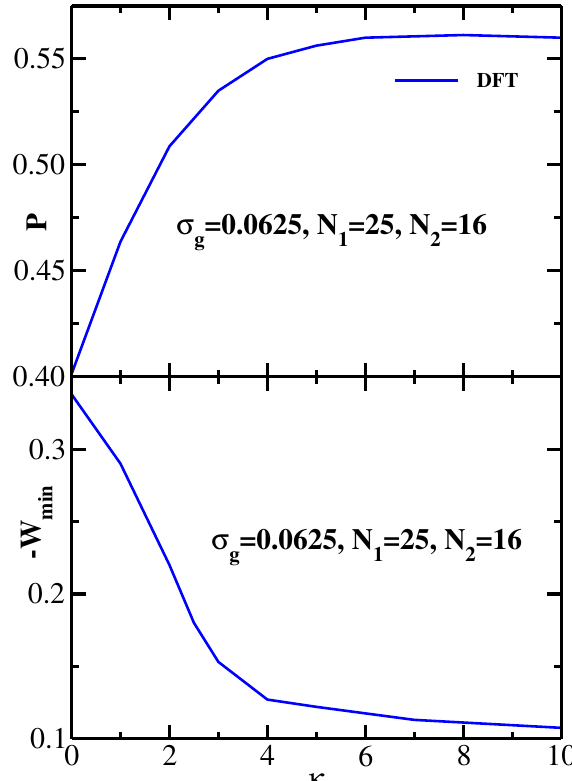
Figure 8. Upper panel: DFT results for the overlap P as a function of the grafted chain stiffness parameter κ for two equimolar bidisperse semiflexible brushes at equilibrium separation; grafting density is σ g = 0.0625 and grafted chain lengths are N 1 = 25 and N 2 = 16. Lower panel: DFT results for the (negative) minimum of the PMF between two equimolar bidisperse semiflexible brushes as a function of the grafted chain stiffness parameter κ ; grafting density is σ g = 0.0625 and grafted chain lengths are N 1 = 25 and N 2 =